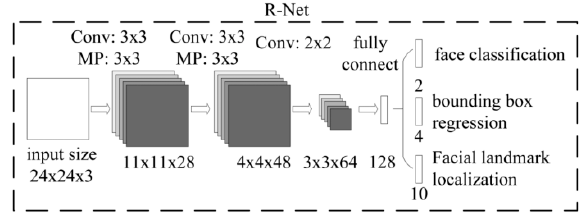
Figure 3. Refine Network (R-Net) structure.